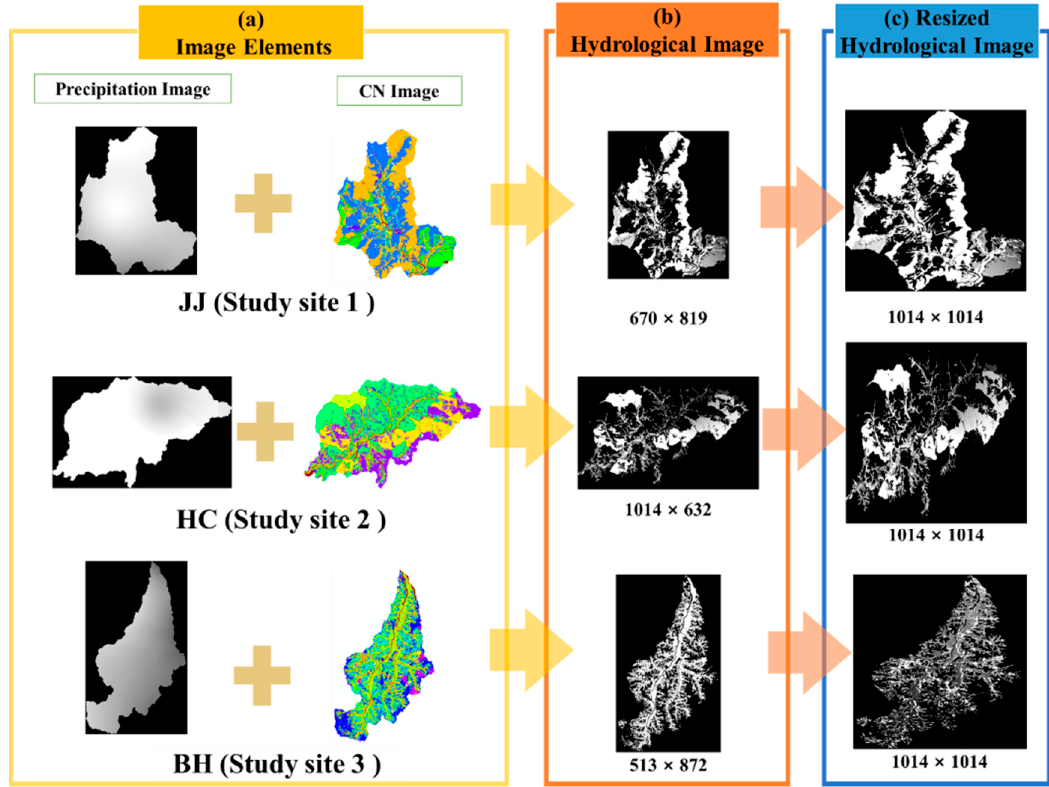
Figure 7. Reconstruction of the hydrological image and size for each study site: ( a ) image elements to build hydrological image, ( b ) the original hydrological image, and ( c ) a resized hydrological image. Table 4. Dataset for CNN